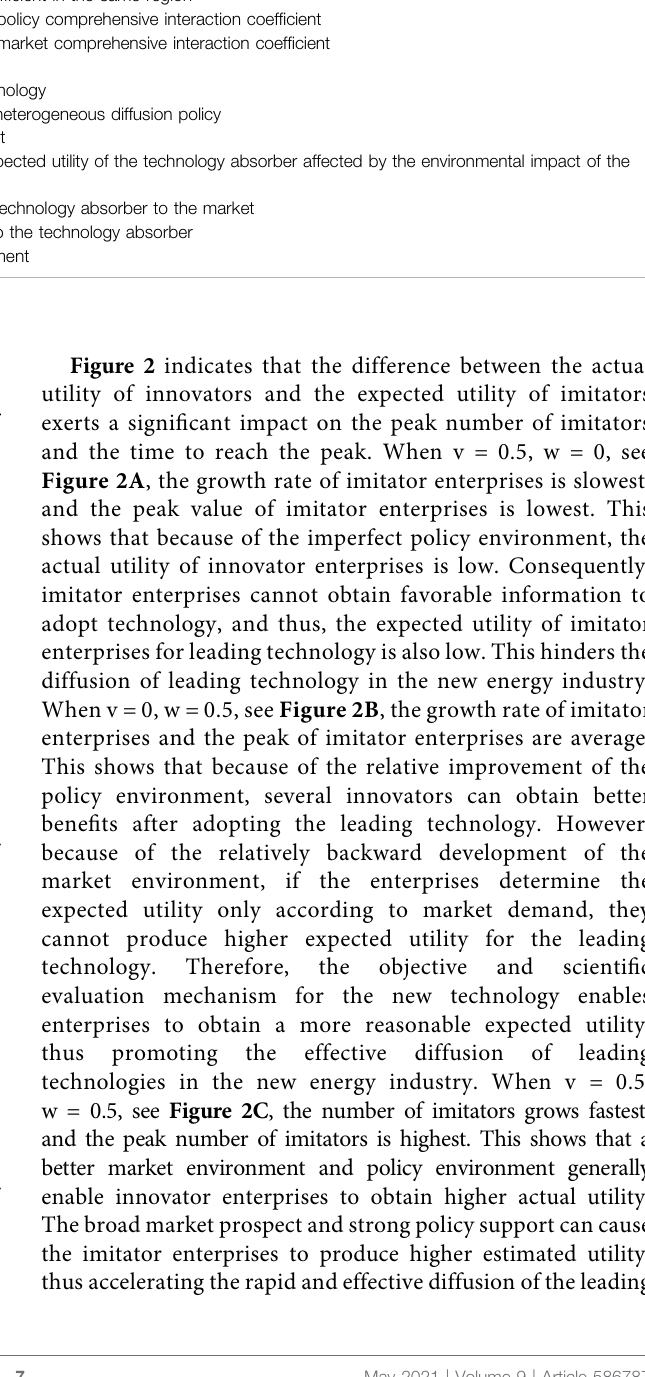
TABLE 1 | The de fi nation of parameters.